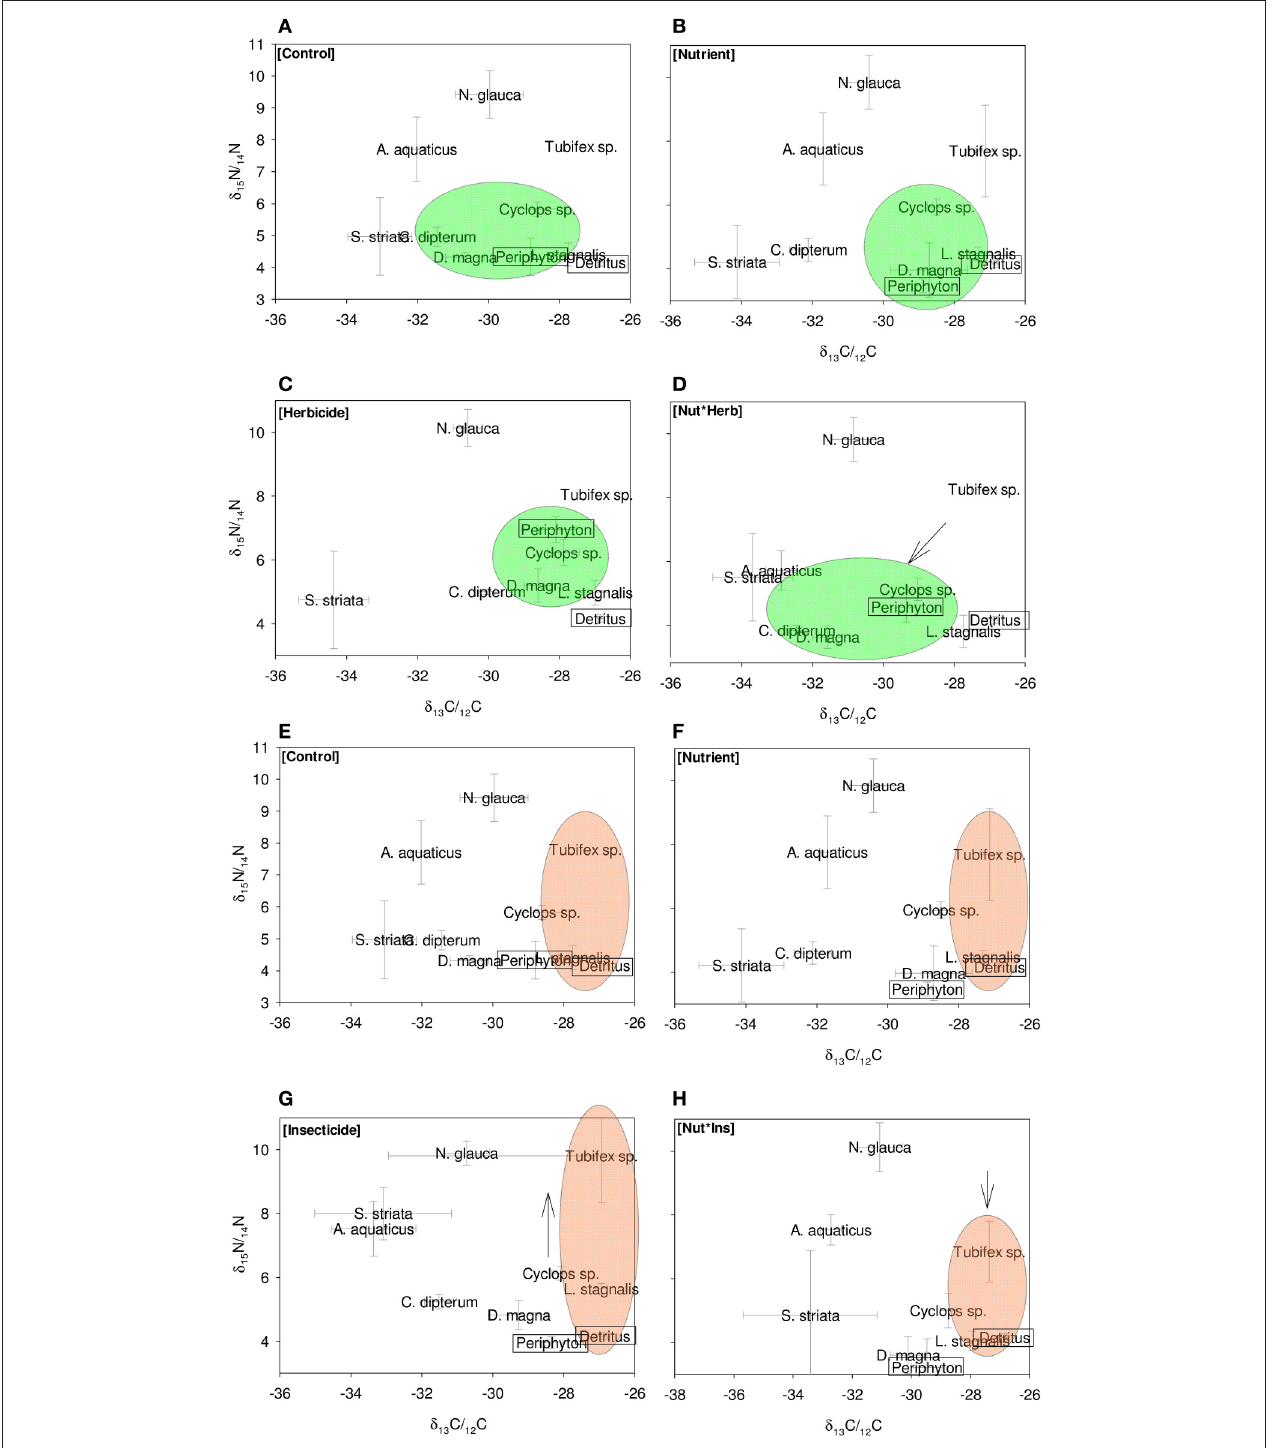
FIGURE 1 | Eight panels showing the most important changes in food webs. (A–D) show effects of the nutrient and herbicide treatment, and interaction between these the on herbivore part of the food web. (E–H) Show food webs in nutrient and insecticide treatment and interaction between these, and the effect on the detritivore part of the food web. Green circles in (A–D) indicate the herbivore energy channel; brown circles in (E–H) indicate the detritivore energy channel. Arrows indicate significant effects of treatments on the herbivore and detritivore channel.